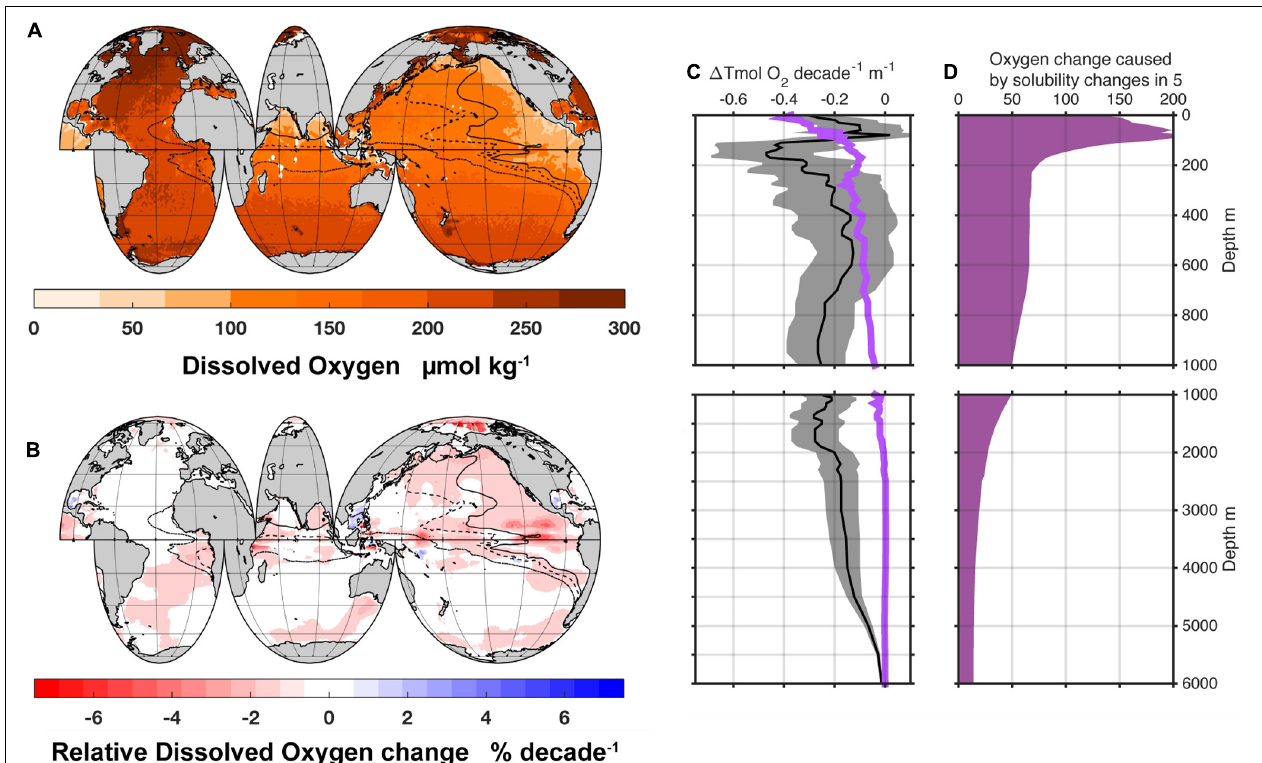
FIGURE 4 | Spatial and temporal trends of dissolved oxygen concentration. (A) Mean oxygen concentration, lines indicate the maximum extent of the oxygen minimum zone with 40, 80, and 120 µ mol kg − 1 dissolved oxygen anywhere in the water column. (B) Trend of oxygen over five decades 1960–2010 (A,B) data from Schmidtko et al., 2017. (C) Vertical distribution of deoxygenation (black curve) and error (gray area), the purple line indicates the loss expected from oceanic warming detected in the same data set. (D) Percentage of deoxygenation due to warming for the water column, values above 100% indicate that processes counter acting solubility deoxygenation are at play (C,D) (reworked from Schmidtko et al.,